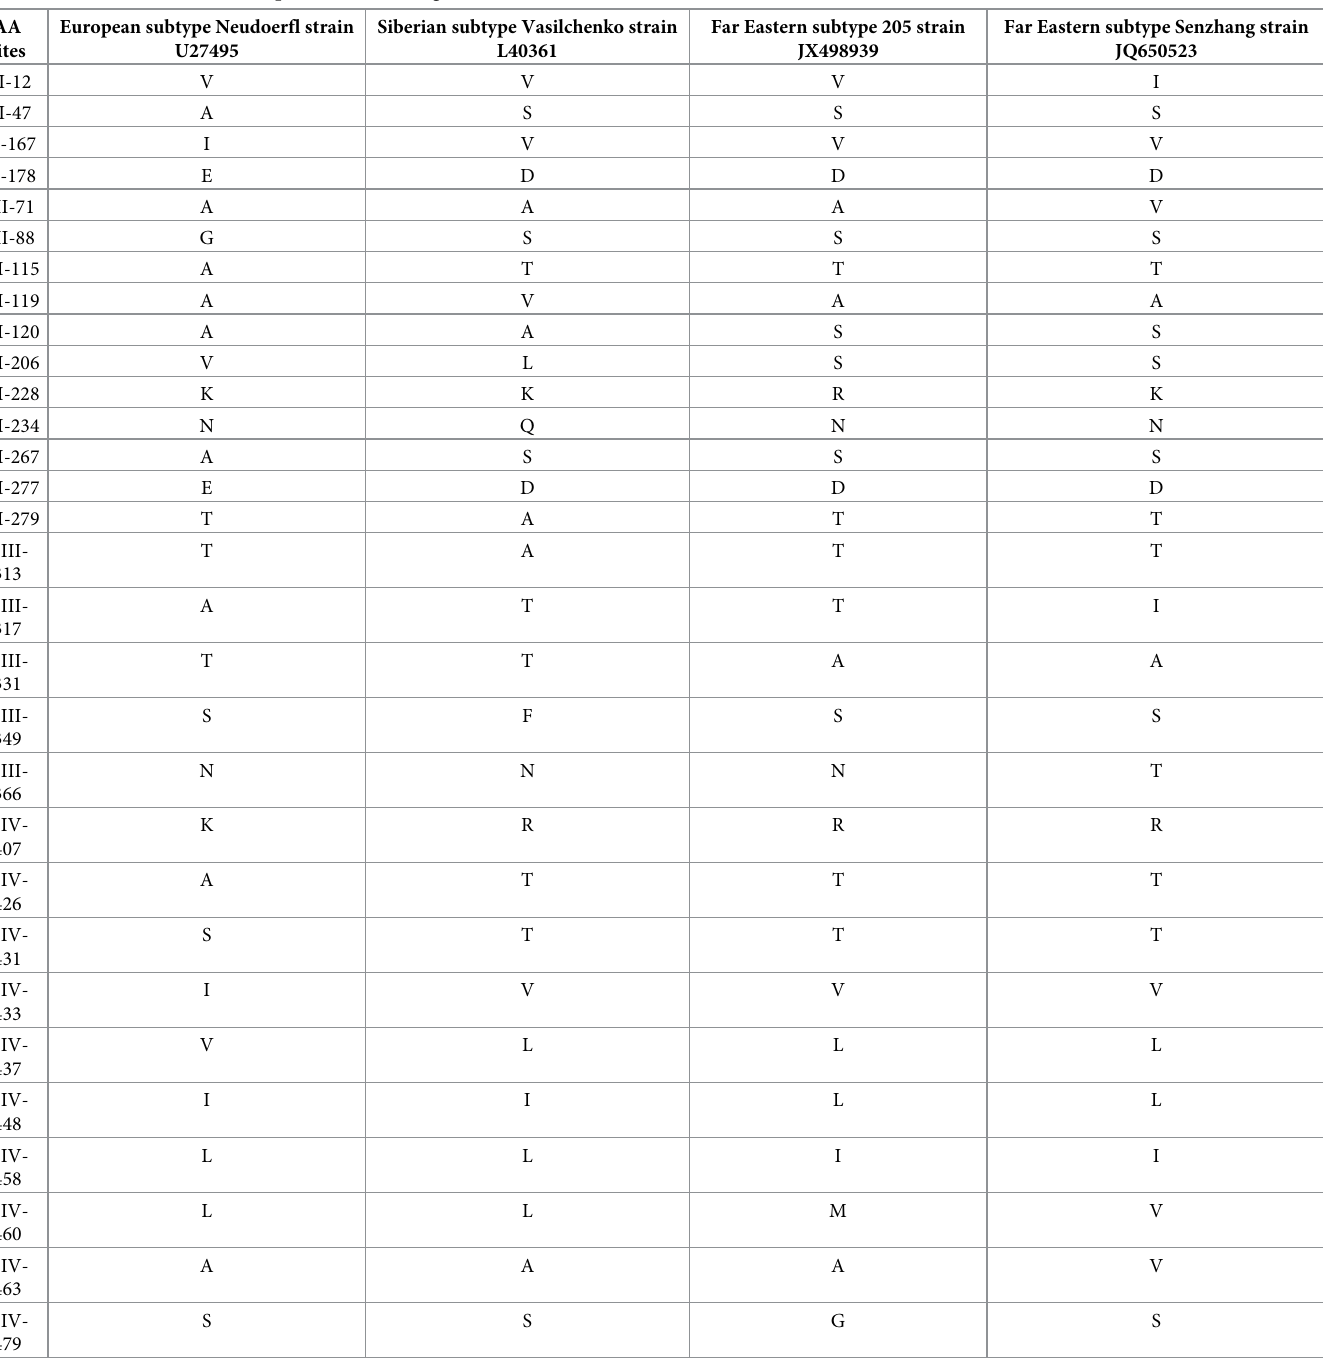
Table 1. AA variation statistics of E protein of Senzhang strain and reference